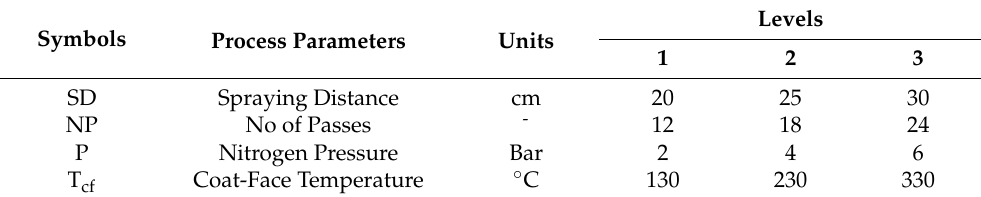
Table 1. Thermal spray process parameters and their levels.